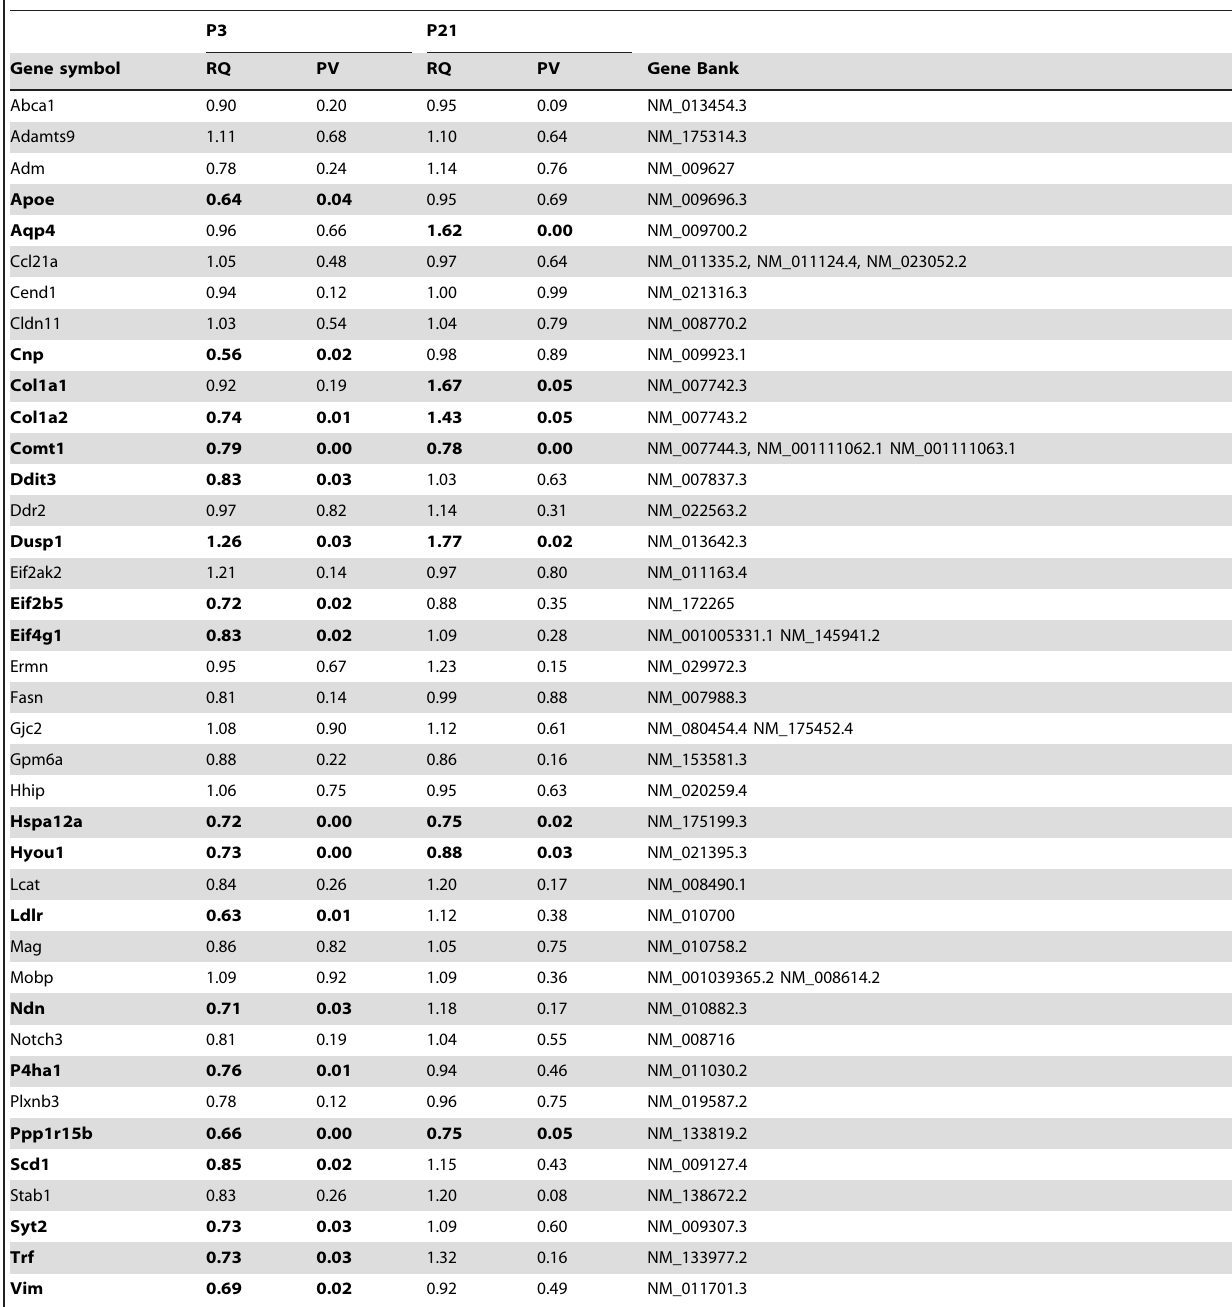
Table 2. Temporal dynamics of differential gene